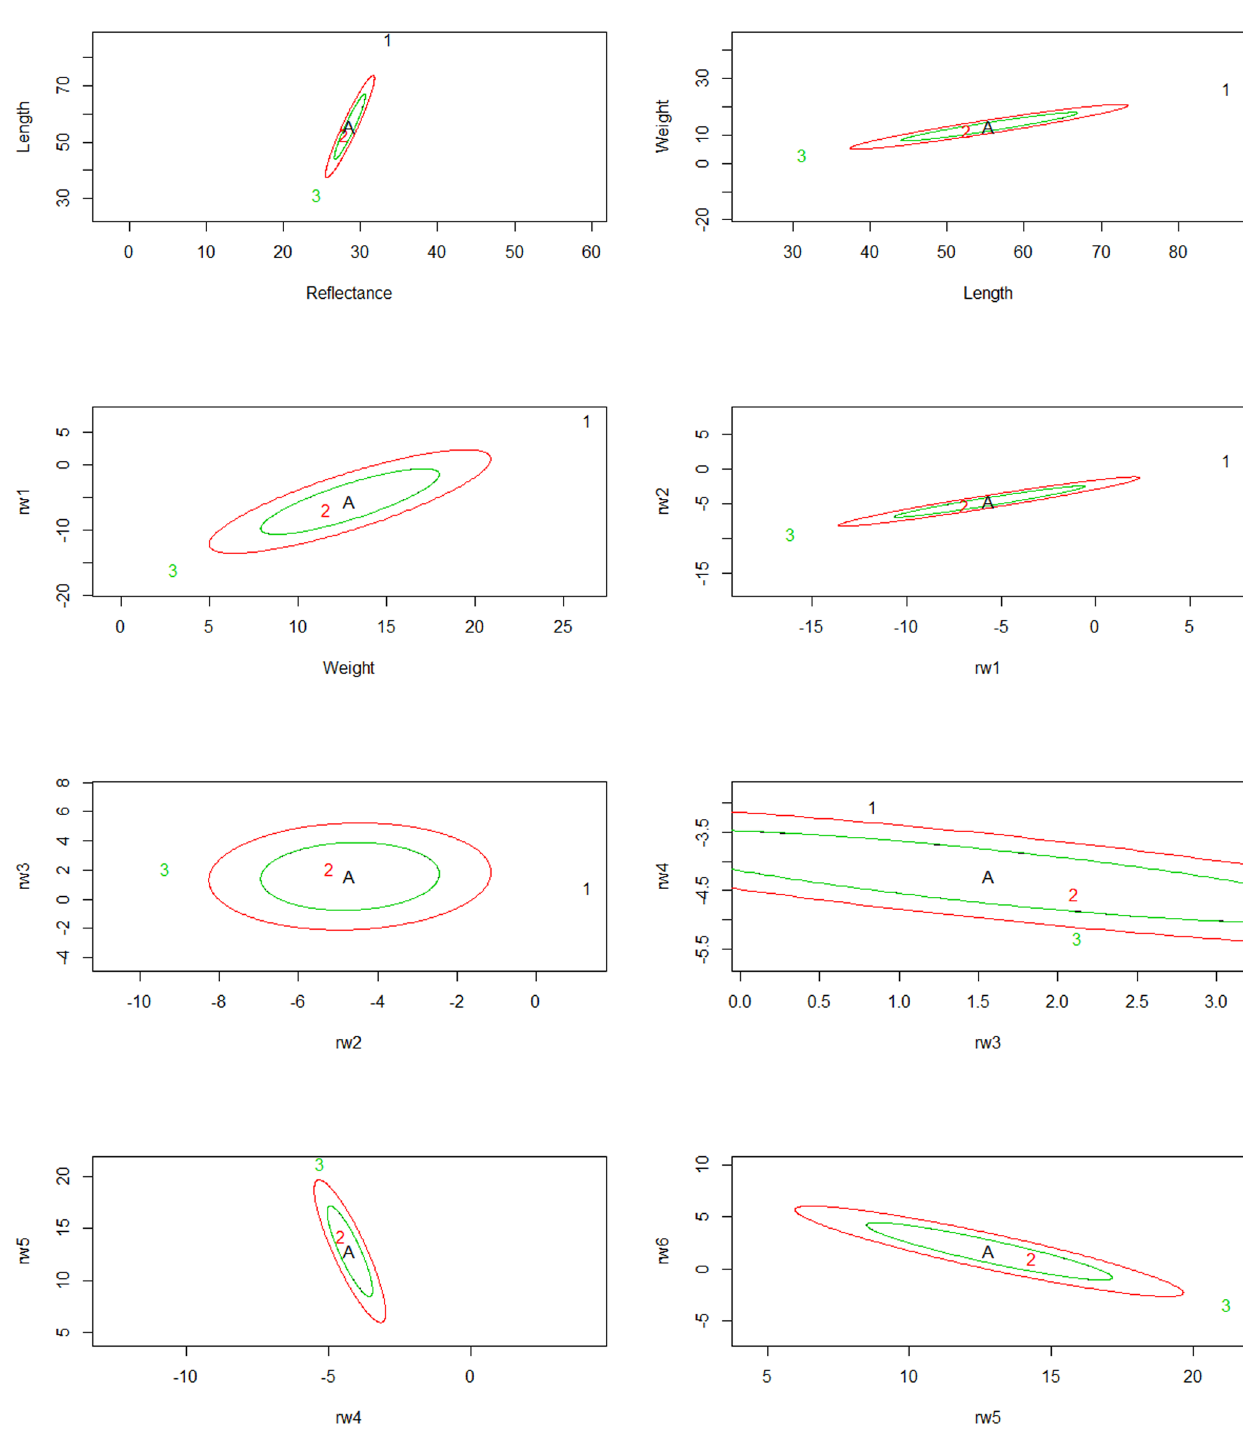
Figure 3. Phenotypic trait distributions for the mean ancestral (A) genotype for trait pairs under neutral expectations at sampling period 1, together with observed population trait values in Assinica (1), Iron River (2), and Siskiwit (3).